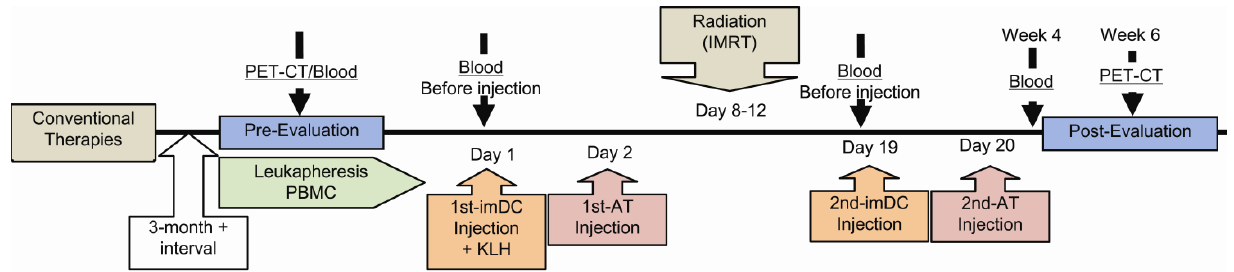
Figure 1. Sequential events in the treatment